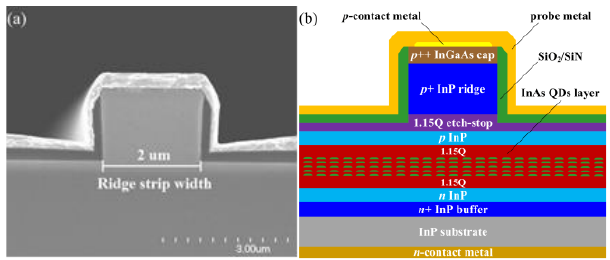
Fig. 1. (a) Cross-sectional SEM image showing the facet of a fabricated F-P InAs/InP QD laser; (b) Schematic cross-sectional diagram of a shallow-etched ridge-waveguide InAs/InP QD laser Fig. 2(a) shows the light output of the lasers as a function of drive current with blue dots for 11 GHz, red dashes for 25 GHz, and green solid for 34.5 GHz lasers at 20°C. Fig. 2 (b) shows the lasing spectra at the indicated drive current for the three lasers. We have investigated optical linewidth for individually filtered longitudinal lasing modes by using an OE4000 automated laser phase noise measurement system and their timing jitters based on their RF beating